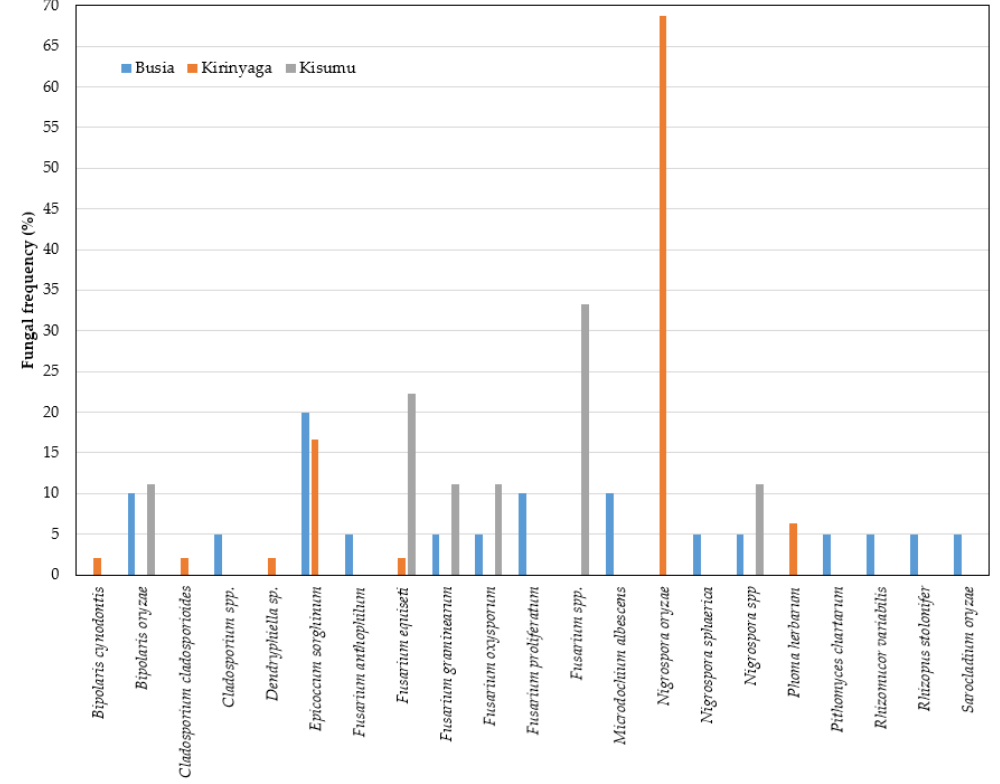
Figure 5. Occurrence of fungal species in rice leaf tissues from Busia, Kirinyaga, and Kisumu counties of Kenya surveyed in 2019.